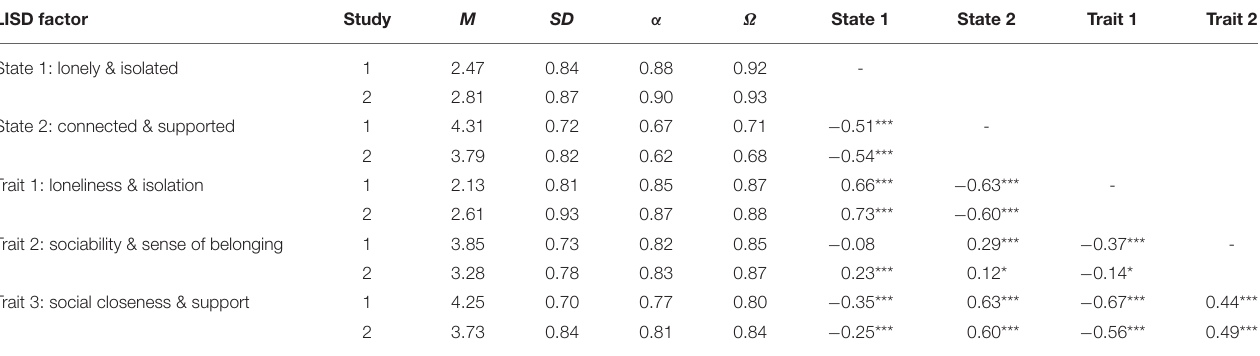
TABLE 2 | Pearson correlations of the five LISD factors for the EFA (Study 1, N = 244) and CFA (Study 2, N = 304) sample. LISD factor Study M SD α Ω State 1 State 2 Trait 1 Trait 2